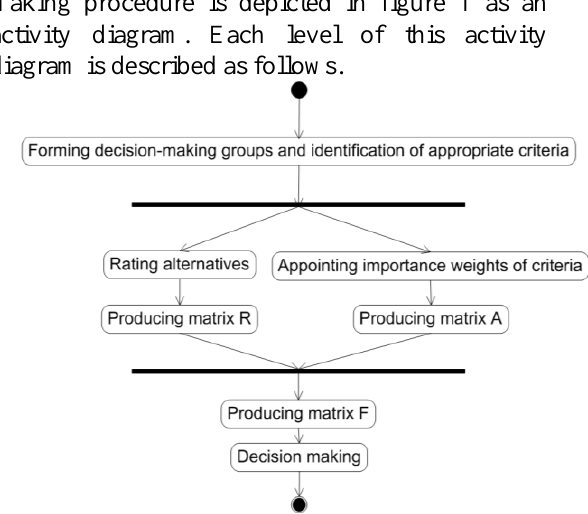
Figure 1. Activity diagram of a fuzzy-based decision- making procedure for selection of a data